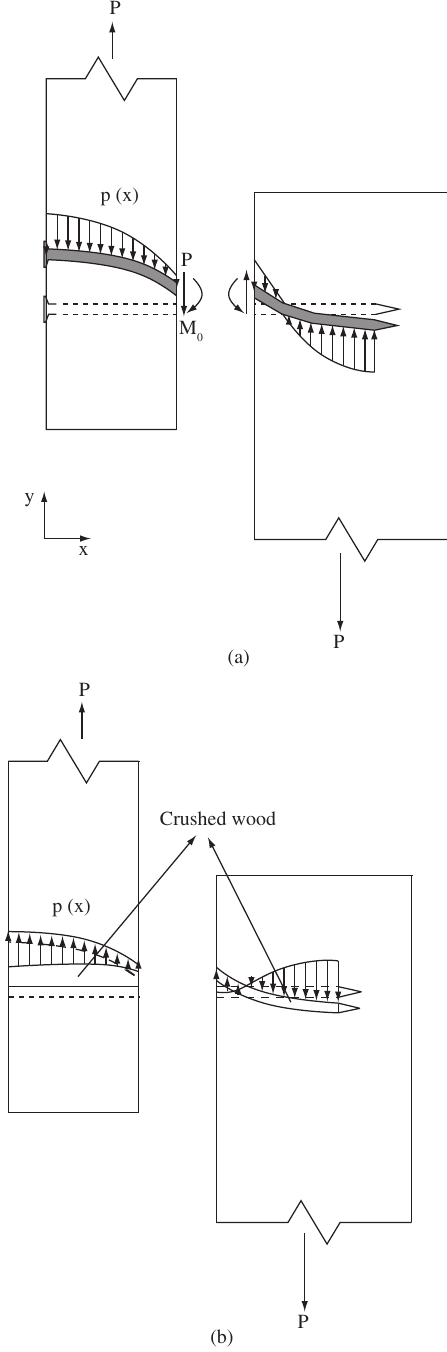
Figure 4. Scheme of the forces acting in the elements of a connection accord- ing to the usual assumption a) reaction of the crushed wood over the nail